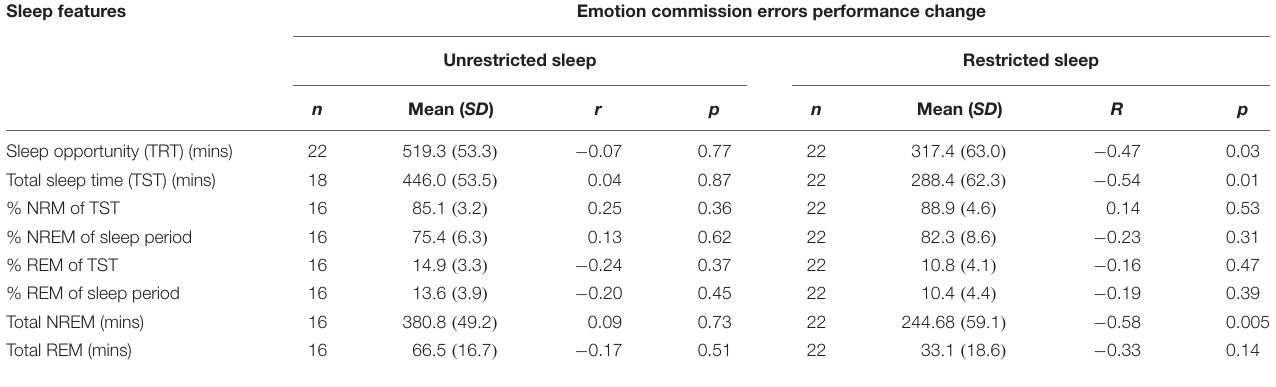
TABLE 3 | Means standard deviations ( SD ) for each polysomnography (PSG) measure for each sleep condition and correlations ( r ) between each PSG measure and difference in immediate and delayed commission errors for each condition. Sleep